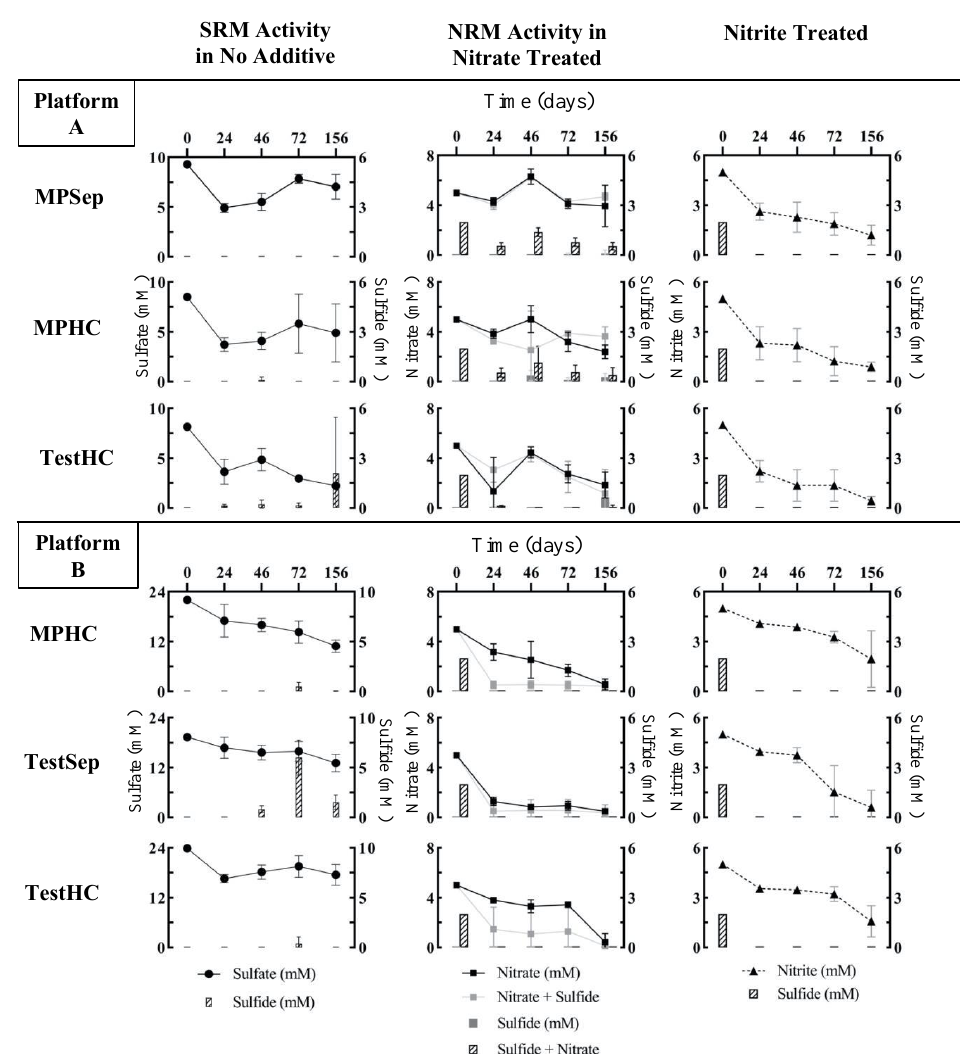
Figure 3. Sulfate, sulfide, nitrate, and nitrite concentrations (mM) in the microcosms over time for Platform ( A ) (top) and ( B ) (bottom) microcosms. The left panel shows the activity of SRMs as determined by sulfate loss and sulfide production over time. The center panel shows the activity of NRMs as determined by nitrate loss over time, and either sulfide production (in nitrate only treatments) or sulfide loss (in S_nitrate treatments where SOM may be active). The data shown in gray corresponds to the nitrate-only treatment, while the data shown in black corresponds to the S_nitrate treatment. The right panel shows the nitrite loss and sulfide loss/production over time. Sulfate (circles), nitrate (squares), and nitrite (triangles) trends are displayed as a continuous line graph, and the sulfide data are displayed as bars. The lack of a bar indicates little or no sulfide. The data points indicate the means of the triplicate incubations, and the error bars represent standard deviation of the mean.